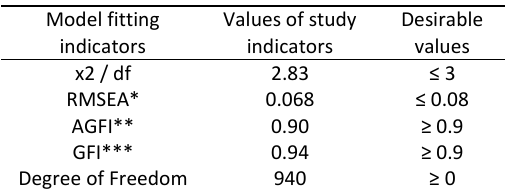
Table 4: Fit indicators of the study model Table 4. Fit indicators of the study